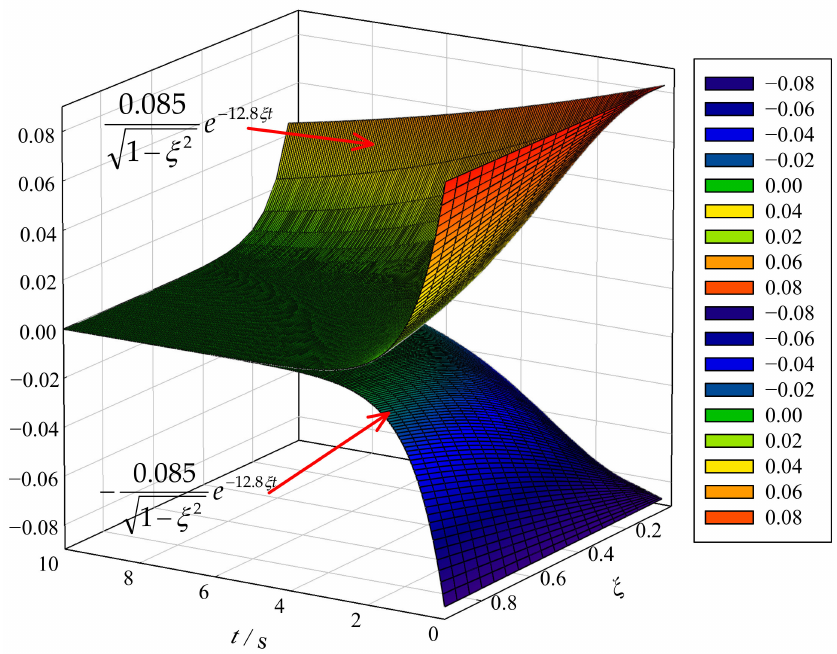
Figure 8. A pair of envelope surfaces of the under-damping anti-swaying system. According to Equation (17), when ∆ and ϕ 0 are known, the attenuation time, t s , of the swaying angle is determined by the damping coefficient, ξ , and the length of the hoisting rope. Figure 9 illustrates this conclusion. Figure 9 also shows that when ξ increases, t s decreases from fast to slow. If ξ is small, then t s increases as l increases; if ξ is large, then t s remains nearly constant as l changes, indicating that when ξ is large, the anti-swaying effect of the system has a certain robustness to the changes in l .